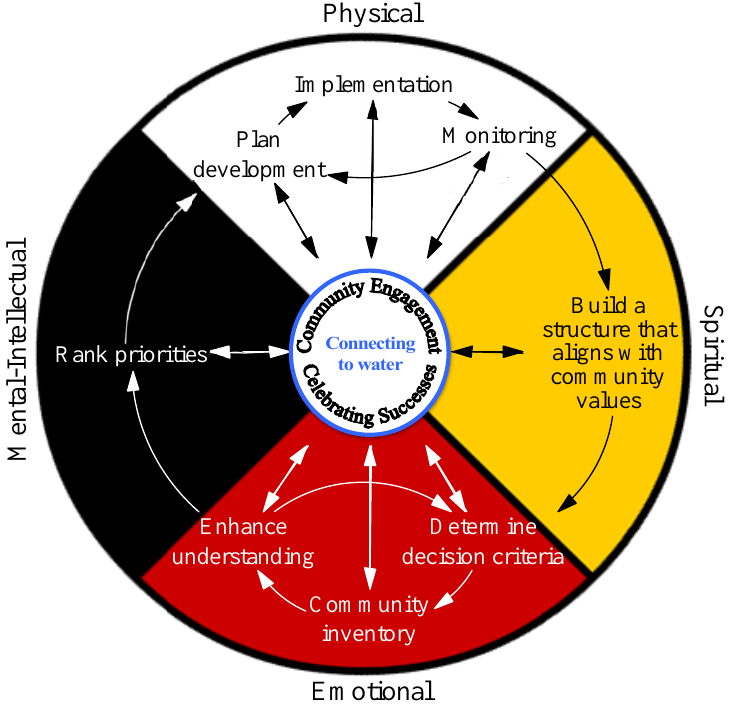
Figure 3. The water protection process and its relation to the Medicine Wheel, based on the teachings of Elder Joanne